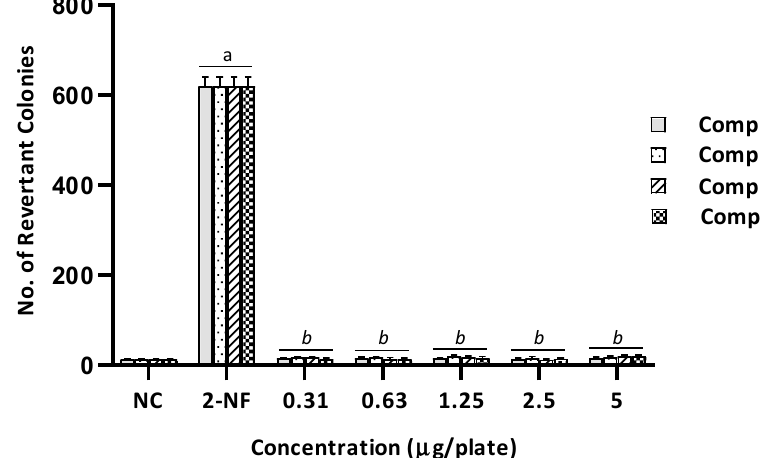
Figure 3. The number of revertant colonies of TA98 strain of Salmonella typhimurium treated with different concentration of benzimidazole derivatives (1–4) in the absence of metabolic activation system ( − S9). NC, Negative control (1% of DMSO in PBS); 2-NF (2-Nitrofluorene), Positive control (2.5 µg/plate). Values were expressed as mean ± SEM of three independent experiments. a, significantly different ( p < 0.05) from the NC group; b , significantly different ( p < 0.05) from the positive control group (2-NF).